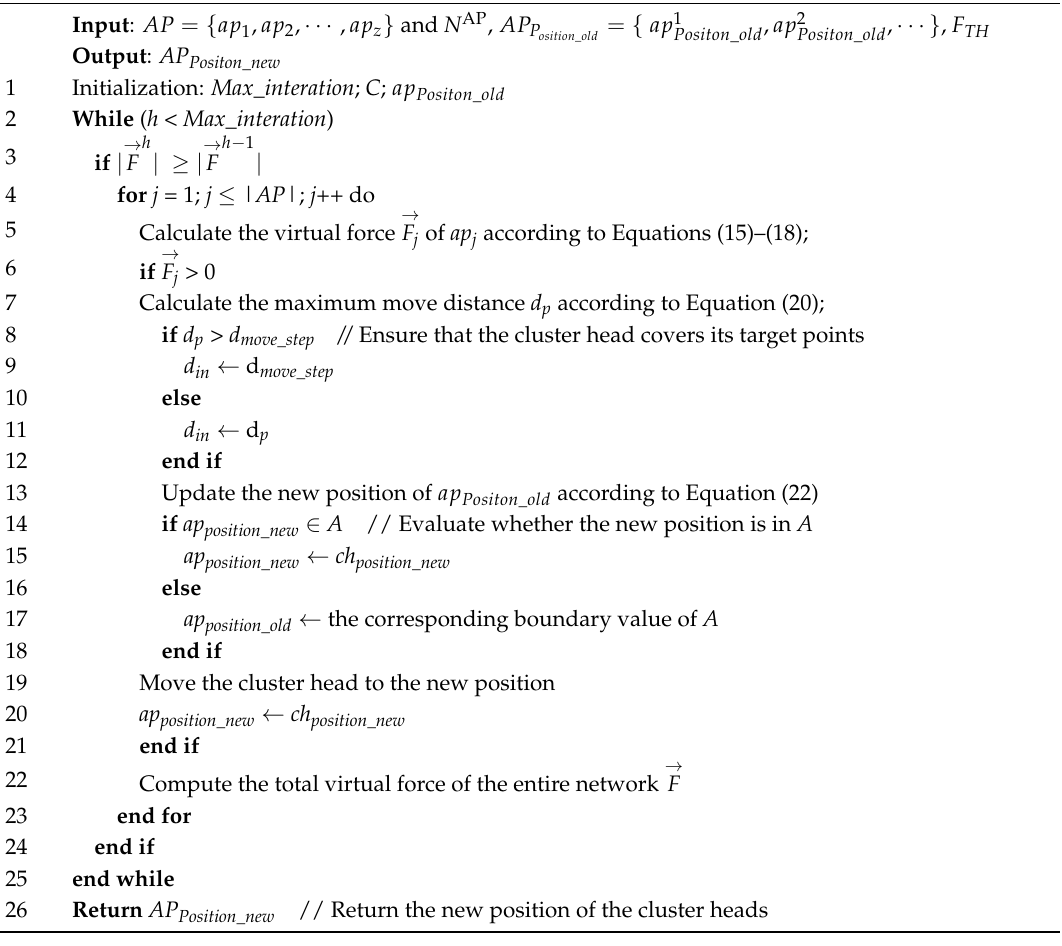
Algorithm 2: The minimum inter-cluster interference strategy based on improved virtual force and